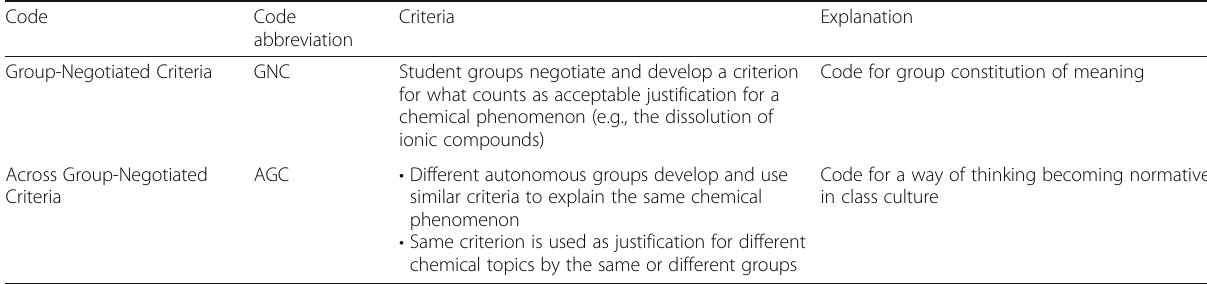
Table 1 Coding scheme and criteria for data analysis